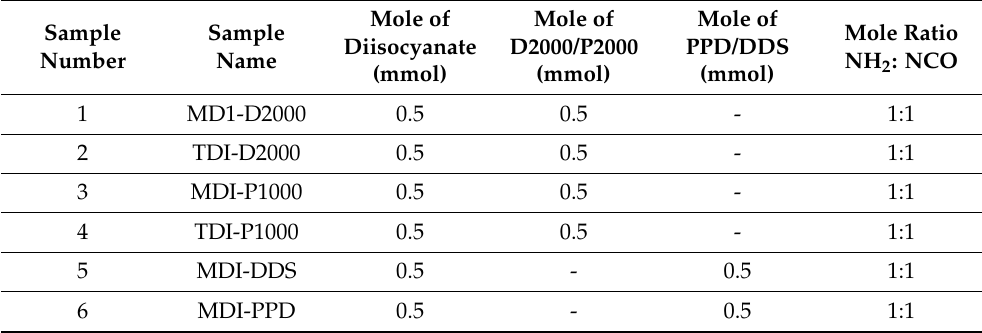
Table 1. Composition of polyurea